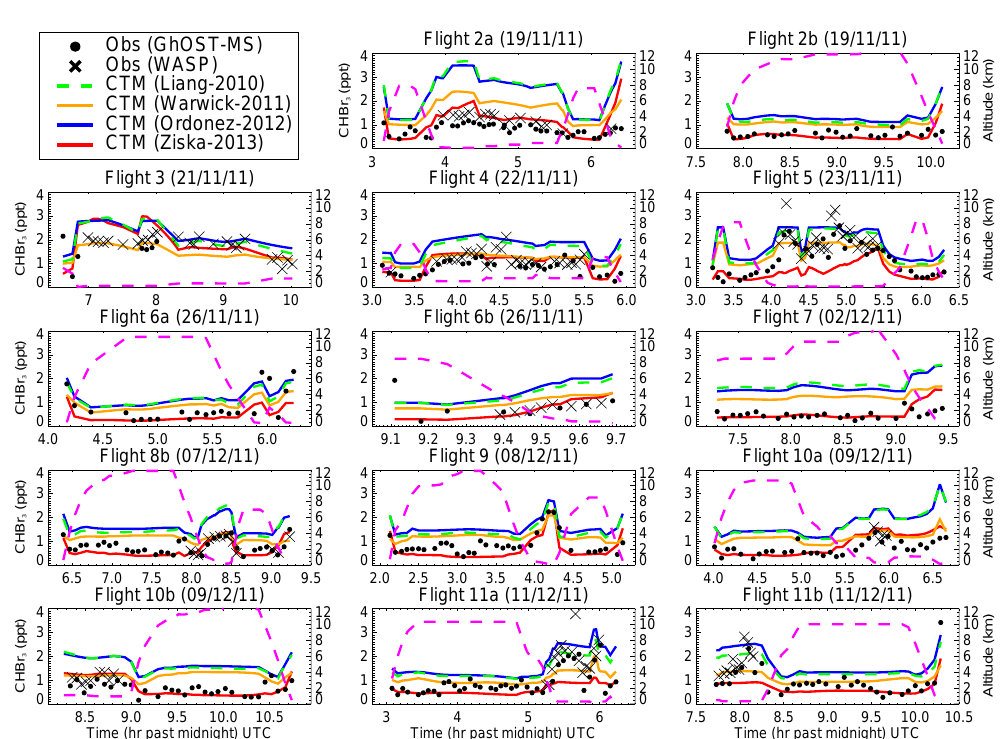
Fig. 11. Comparison between modelled and observed CHBr 3 mixing ratio (ppt) along the flight tracks of the DLR Falcon aircraft during the 2011 SHIVA campaign. Model output is from CTM runs S Liang , S Warwick , S Ordonez and S Ziska and observed data from the GhOST in situ GC/MS system and the WASP whole air sampler (Sala et al., 2013). The dashed pink line denotes the altitude of the